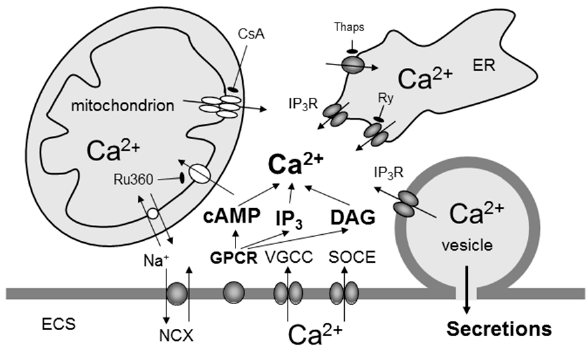
Figure 2. Interactions between Ca 2+ and cAMP signalling for regulated vesicle-based secretion from astrocytes. The accumulation of Ca 2+ in the cytosol may occur (1) following the entry of Ca 2+ from the extracellular space (ECS) through L-type voltage-gated channels (VGCC), store-operated Ca 2+ entry (SOCE) via transient receptor potential canonical type 1-containing channels, and the plasma membrane Na + /Ca 2+ exchanger (NCX), and (2) via G protein-coupled receptor (GPCR) activation, which can generate the additional second messengers cAMP, inositol 1,4,5 triphosphate (IP 3 ), and diacylglycerol (DAG). T bar denotes inhibition, arrows Ca 2+ flux direction and interactions between second messengers. The GPCR activation in astrocytes retrieves Ca 2+ from the endoplasmic reticulum (ER) internal stores that possess IP 3 receptors (IP 3 R) as well as from ryanodine (Ry)-sensitive channels acting as conduits for Ca 2+ delivery to the cytosol. The ER store is (re)filled by Ca 2+ -ATPase (i.e., SERCA pumps), which can be blocked by thapsigargin (Thaps). Cytosolic Ca 2+ levels are modulated by mitochondria. These organelles take up Ca 2+ via the Ca 2+ uniporter, which is blocked by ruthenium 360 (Ru360), during the cytosolic Ca 2+ increase. As cytosolic Ca 2+ decreases due to the extrusion mechanisms, Ca 2+ is slowly released by mitochondria into the cytosol via the mitochondrial Na + /Ca 2+ exchanger as well as by the transient opening of the mitochondrial permeability transition pore. This transient opening is indirectly blocked by cyclosporin A (CsA), which binds cyclophilin D (not shown). The increase in cytosolic Ca 2+ levels is sufficient and necessary to cause the fusion of secretory vesicles (which themselves can act as IP 3 -sensitive stores for Ca 2+ ) with the plasma membrane, mediating the exit of gliosignalling molecules (such as amino acids, peptides, and ATP) from the vesicle lumen into the ECS. The cAMP-mediated modulation of Ca 2+ homeostasis may occur at the level of Ca 2+ entry or extrusion from the cytosol. Moreover, cAMP-mediated mechanisms may directly affect the fusion pore and the extrusion of gliosignals from the vesicle lumen. Drawing is not to scale. Reproduced with permission [104].